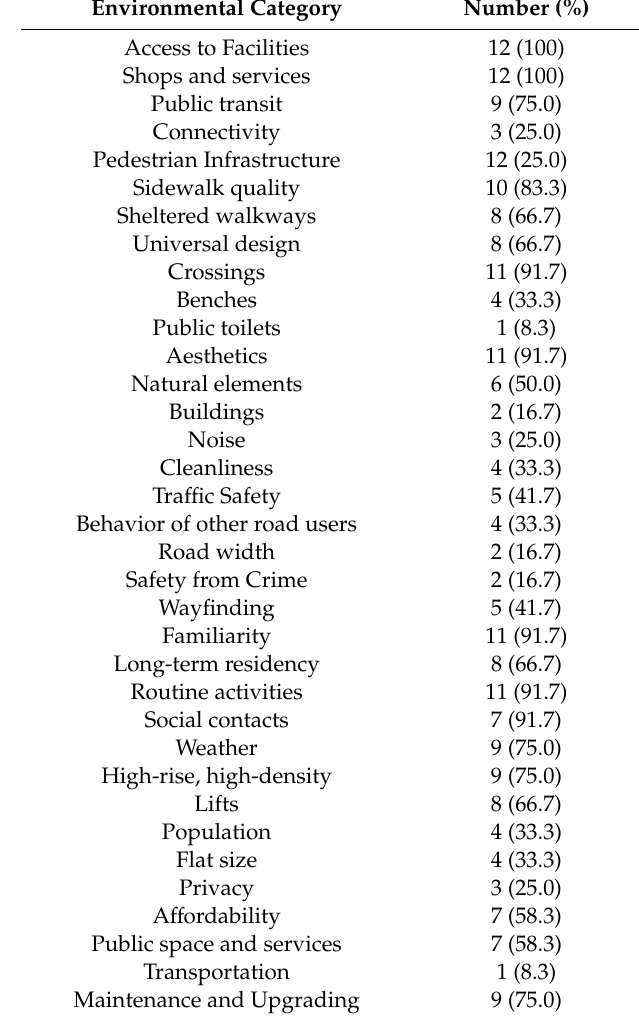
Table A1. Numbers and percentages of participants that discussed an environmental category, N =